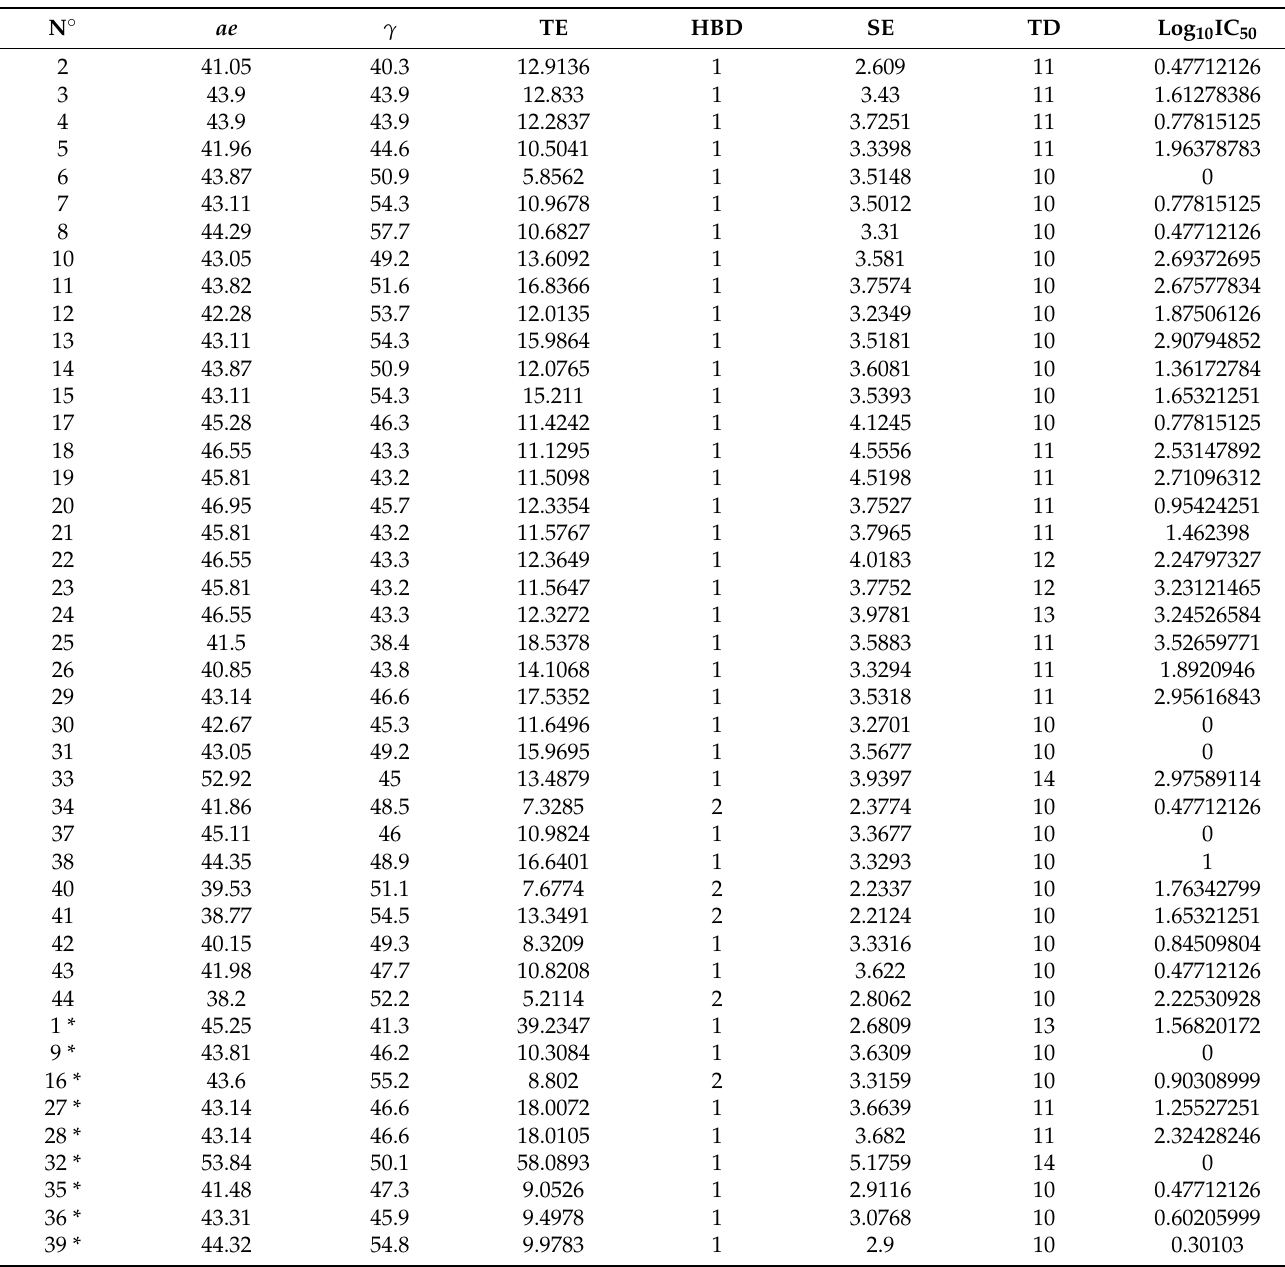
Table 1. The values of selected descriptors for 44 molecules.